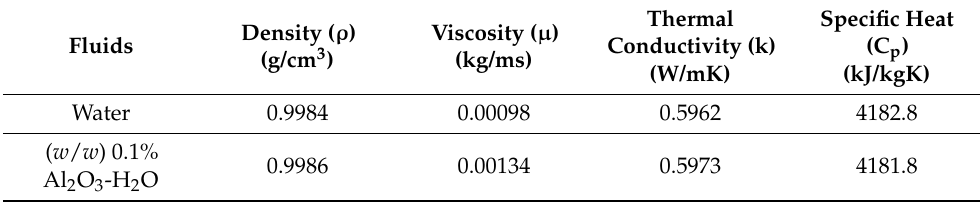
Table 3. Thermophysical properties of the base fluid and